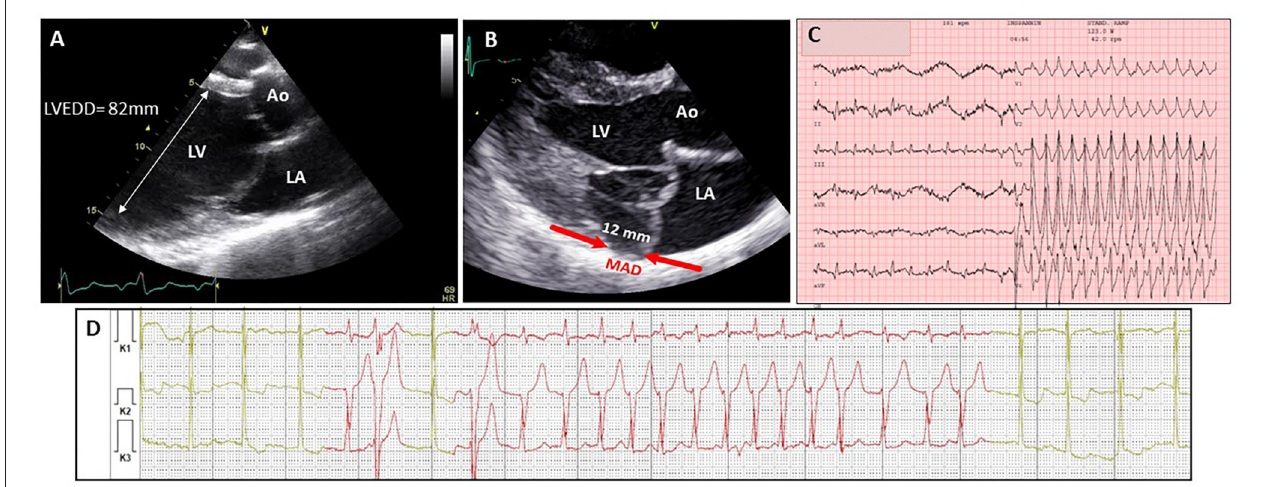
FIGURE 2 | Different manifestations of myocardial disease in classical Marfan syndrome. (A) Echocardiographic image (2D TTE PSLAX view) in a 16 yr old male showing severe dilatation of the left ventricle. (B) Echocardiographic image (2D TTE PSLAX view) showing mitral annular disjunction. (C) ECG recordings in 28 yr old male showing ventricular tachycardia followed by presyncope during exercise test 6 m after mitral valve surgery and aortic root replacement (D) ambulatory electrocardiogram recording in a 57 yr old female with frequent episodes of non-sustained ventricular tachycardia. Ao, aorta; LA, left atrium; LV, left ventricle; LVEDD, left ventricular end-diastolic diameter; MAD, mitral annular disjunction.